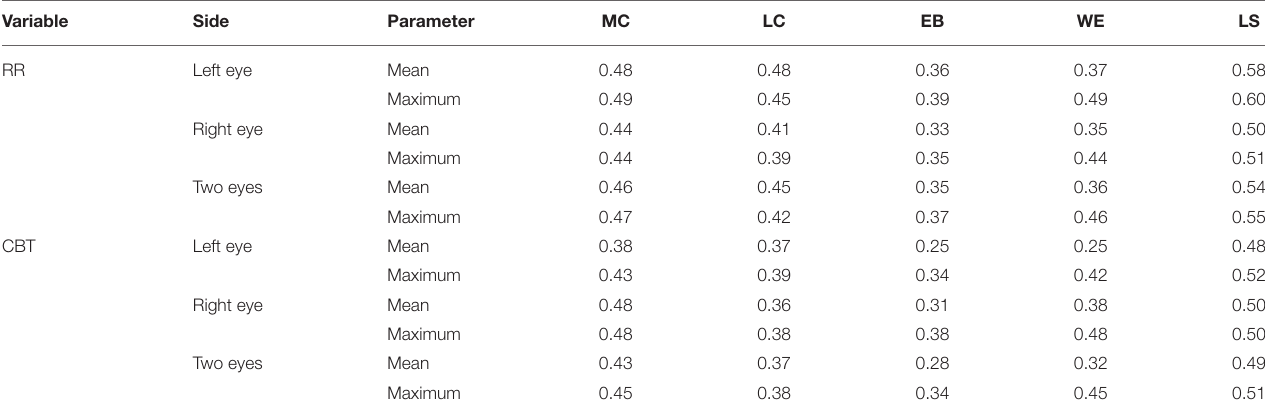
TABLE 3 | Correlation coefficients of mean and maximum eye temperature ( ◦ C, left and/or right) with respiration rate (RR, breaths/min) and core body temperature (CBT, ◦ C). Variable Side Parameter MC LC EB WE RR Left